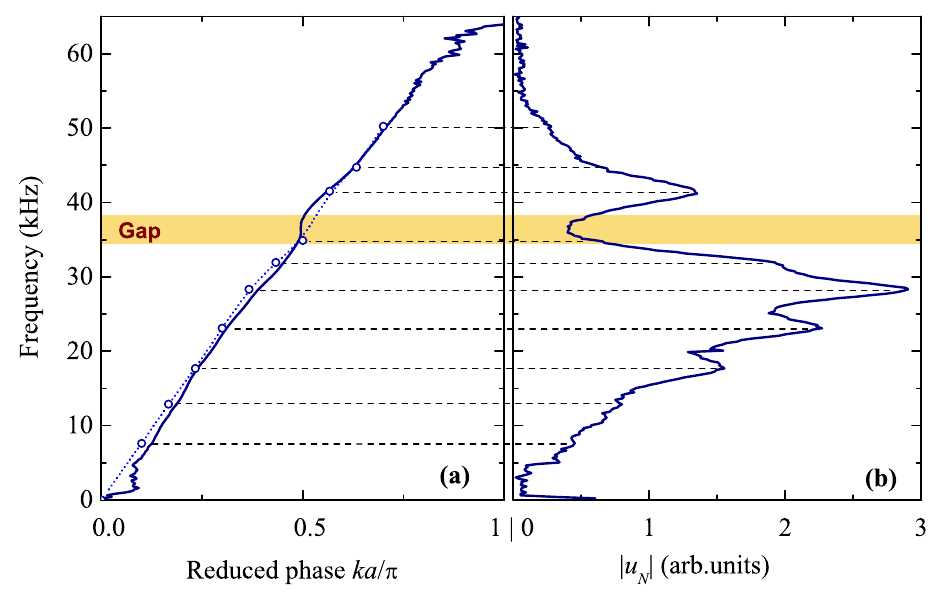
Figure 9. ( a ) experimental dispersion plot of a linear chain of lattice parameter a , made of N touching spheres (diameter d = a = 3 mm); ( b ) experimental transmitted displacement field spectrum for the case of a finite chain ( N = 15). All symbols, methods and analysis follow the same scheme as the one used in Figure